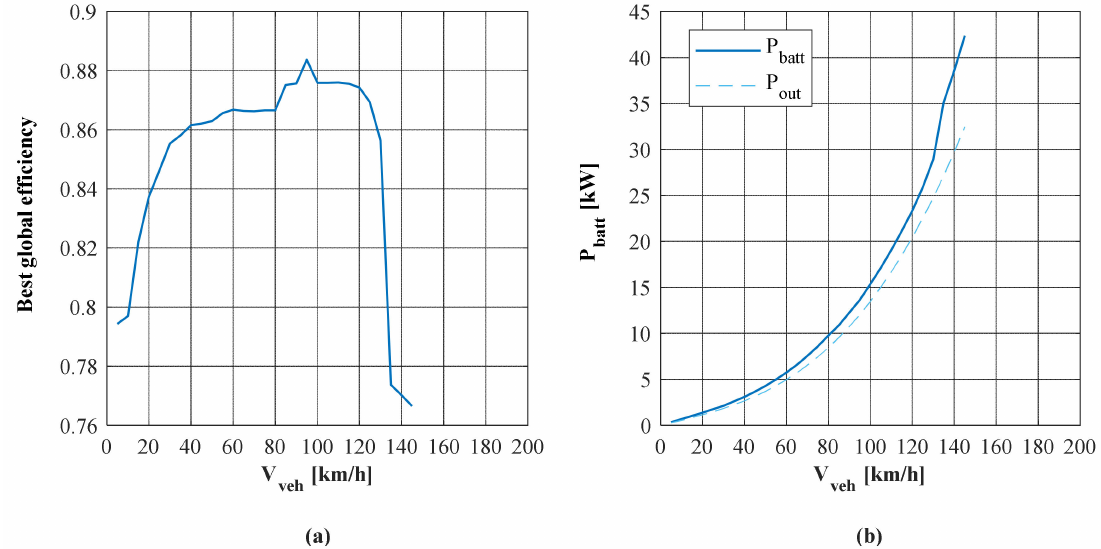
Figure 12. ( a ) Best global efficiency in FEV operation; ( b ) battery power in the optimal FEV operating points.